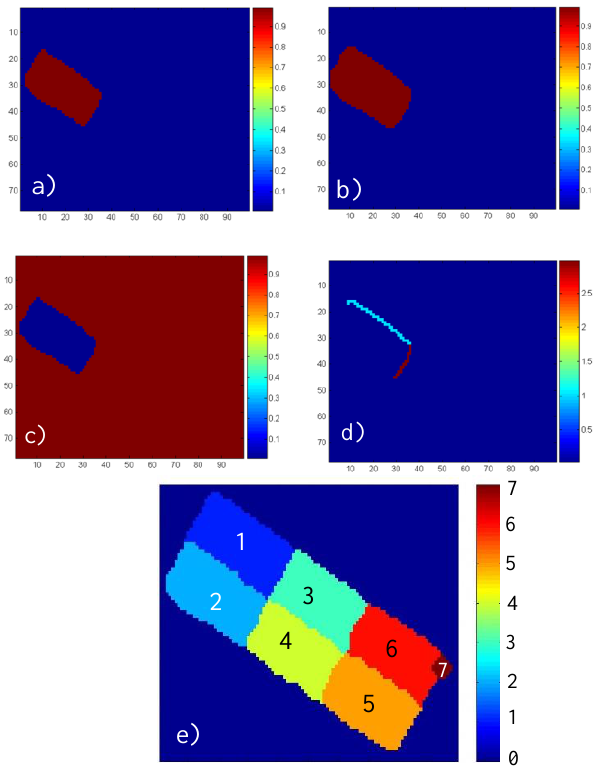
Figure 1. Calculation of the plane_adjacent matrix. Visualisation of a) the binary matrix plane_2 ; b) the matrix plane2_extended ; c) the matrix negative_p2 ; d) the matrix plane_2_adjacent ; and e) Building label image. The colours in